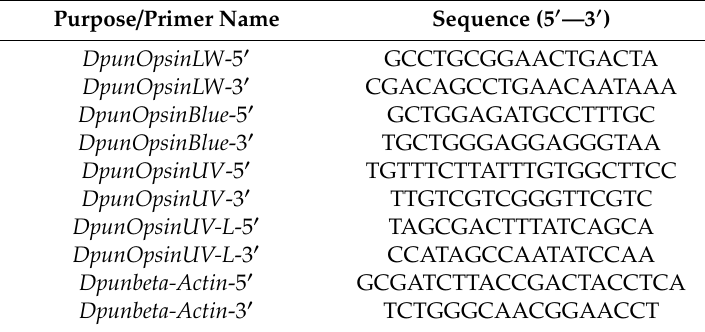
Table 1. Primers used for real-time